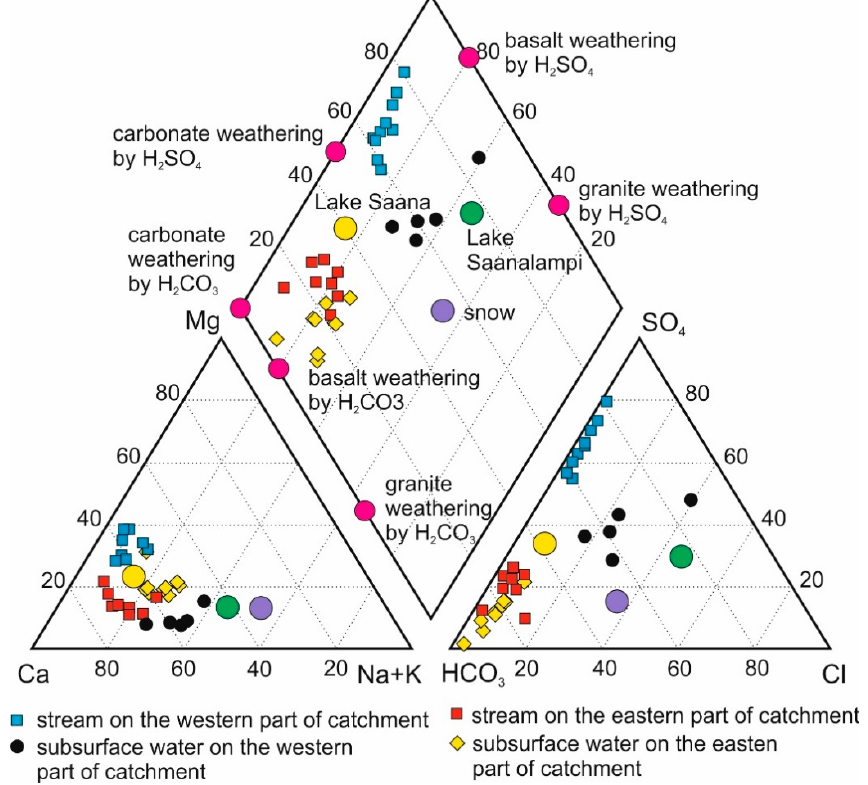
Figure 8. Piper diagram of Lake Saana catchment waters illustrating contributions from weathering of major rock types by carbonic acid and sulphuric acid after Spence and Telmer [33]. Chemical data of lakes is presented in the Supplementary Information B. Bicarbonate is calculated based on the charge balance of the solution.